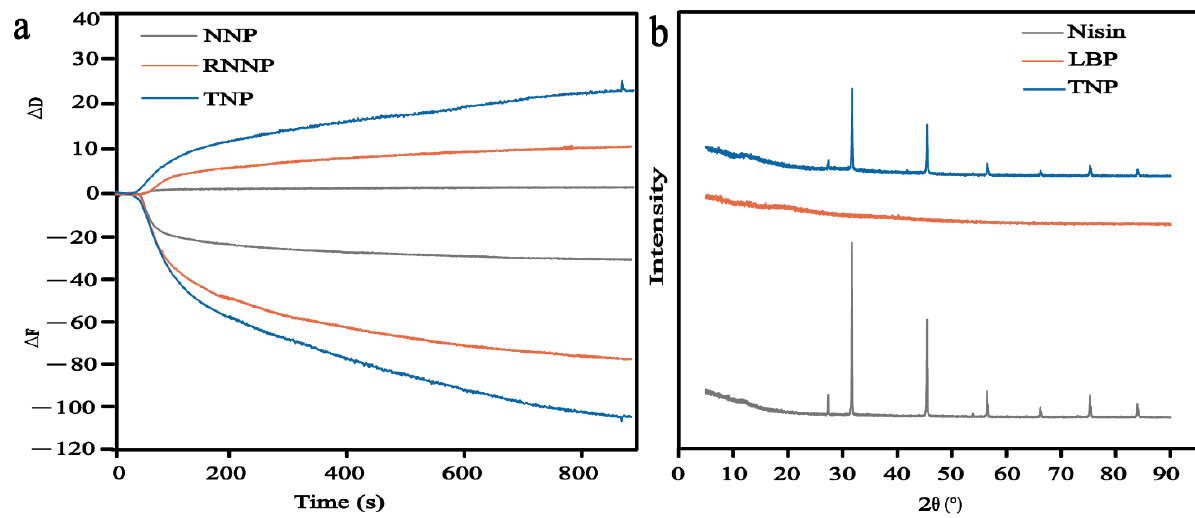
Figure 3. QCM of NNP, RNNP and TNP ( a ); XRD of Nisin, LBP and TNP( b ).